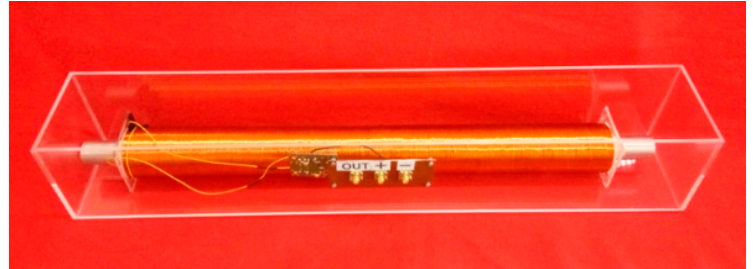
Figure 2. The magnetic antenna with 90,000 turns and 60 cm long inside a plexiglass enclosure.